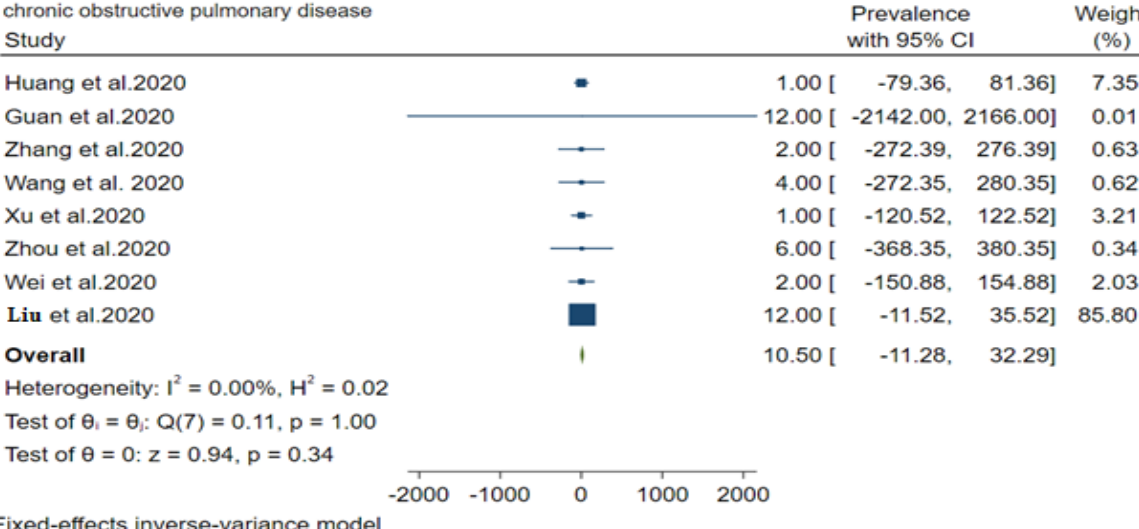
Figure 4. Forest plots showed the prevalence of the chronic obstructive pulmonary disease amongst COVID-19